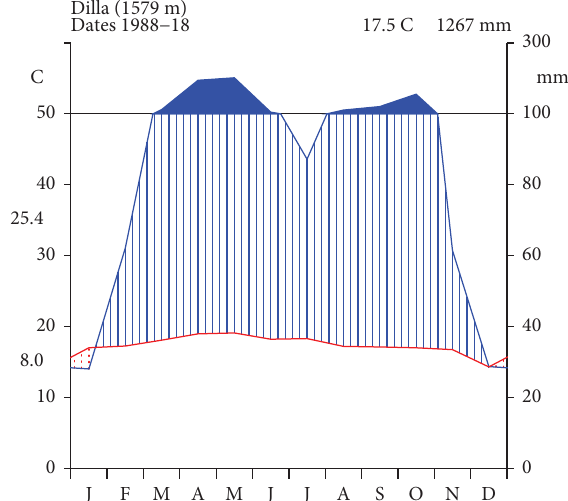
Figure 2: Map of climatic diagram of the district (Source: National Metrological Agency